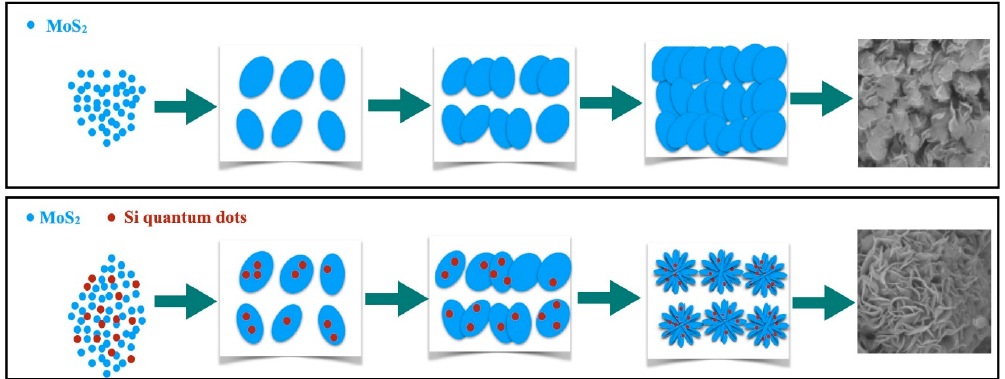
Figure 4. Schematic illustration of the formation for MoS 2 and Si/MoS 2 composite.